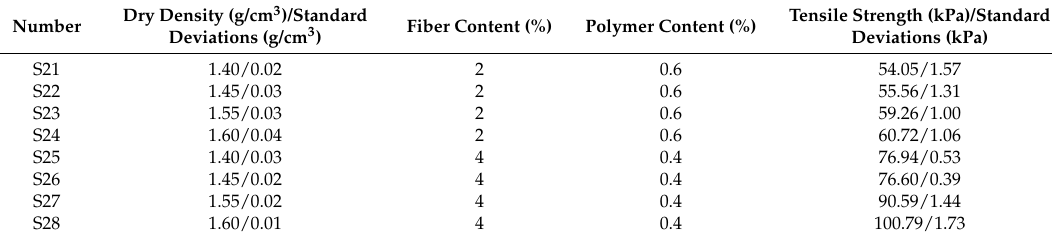
Table 5. The relevant parameters and the tensile test results of additional